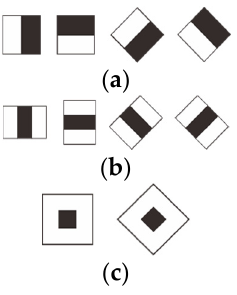
Figure 3. Haar-like features: ( a ) Edge, ( b ) line, ( c )